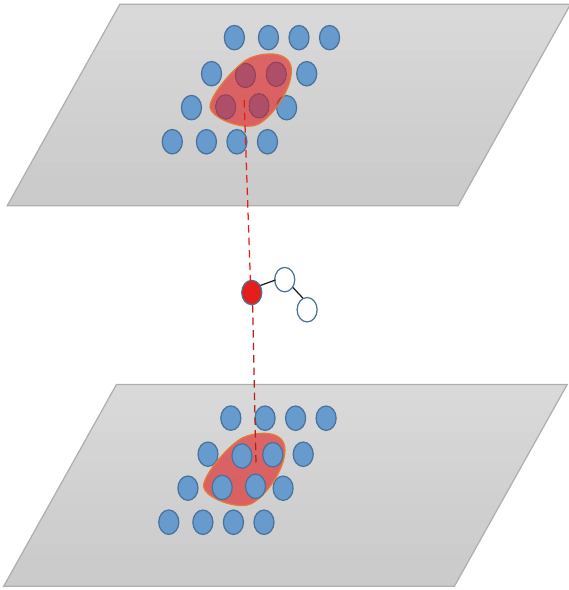
Figure 1: Atom-atom model of Casimir energy interaction of water molecule with the four atoms, covered by the projection of molecule on the surface of the upper and lower